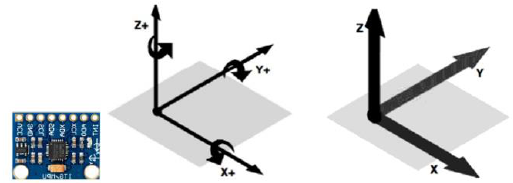
Figure 26. HX711 Electronic Scales. Figure 25. Accelerometer axis and accelerometer axis of